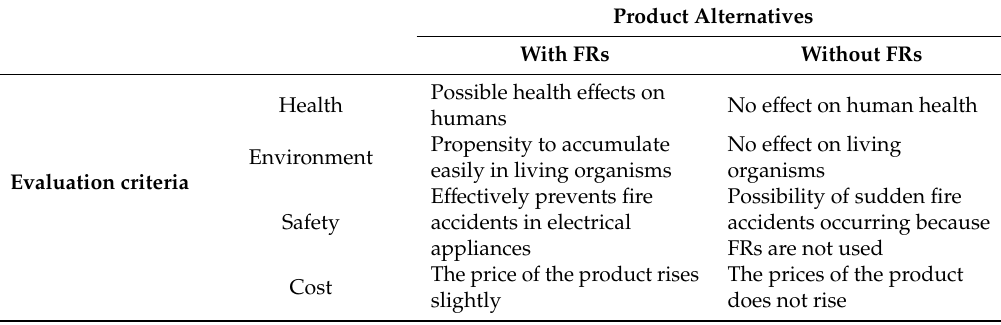
Table 3. Explanation of E&E 1 products with / without FRs 1